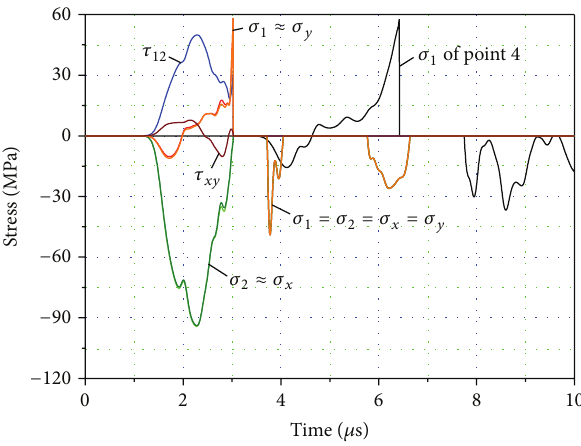
Figure 6: Stresses change of the element containing point 3.